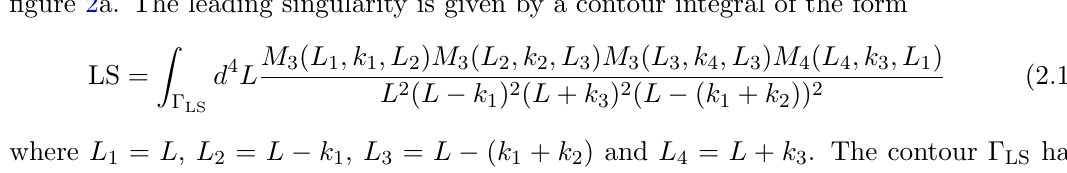
Figure 1. Scattering process of massive scalars. Throughout the text we will extensively discuss the case m 1 = m 2 = m a and m 3 = m 4 = m b . Note that all momenta are incoming. (cid:12)gure 2a. The leading singularity is given by a contour integral of the